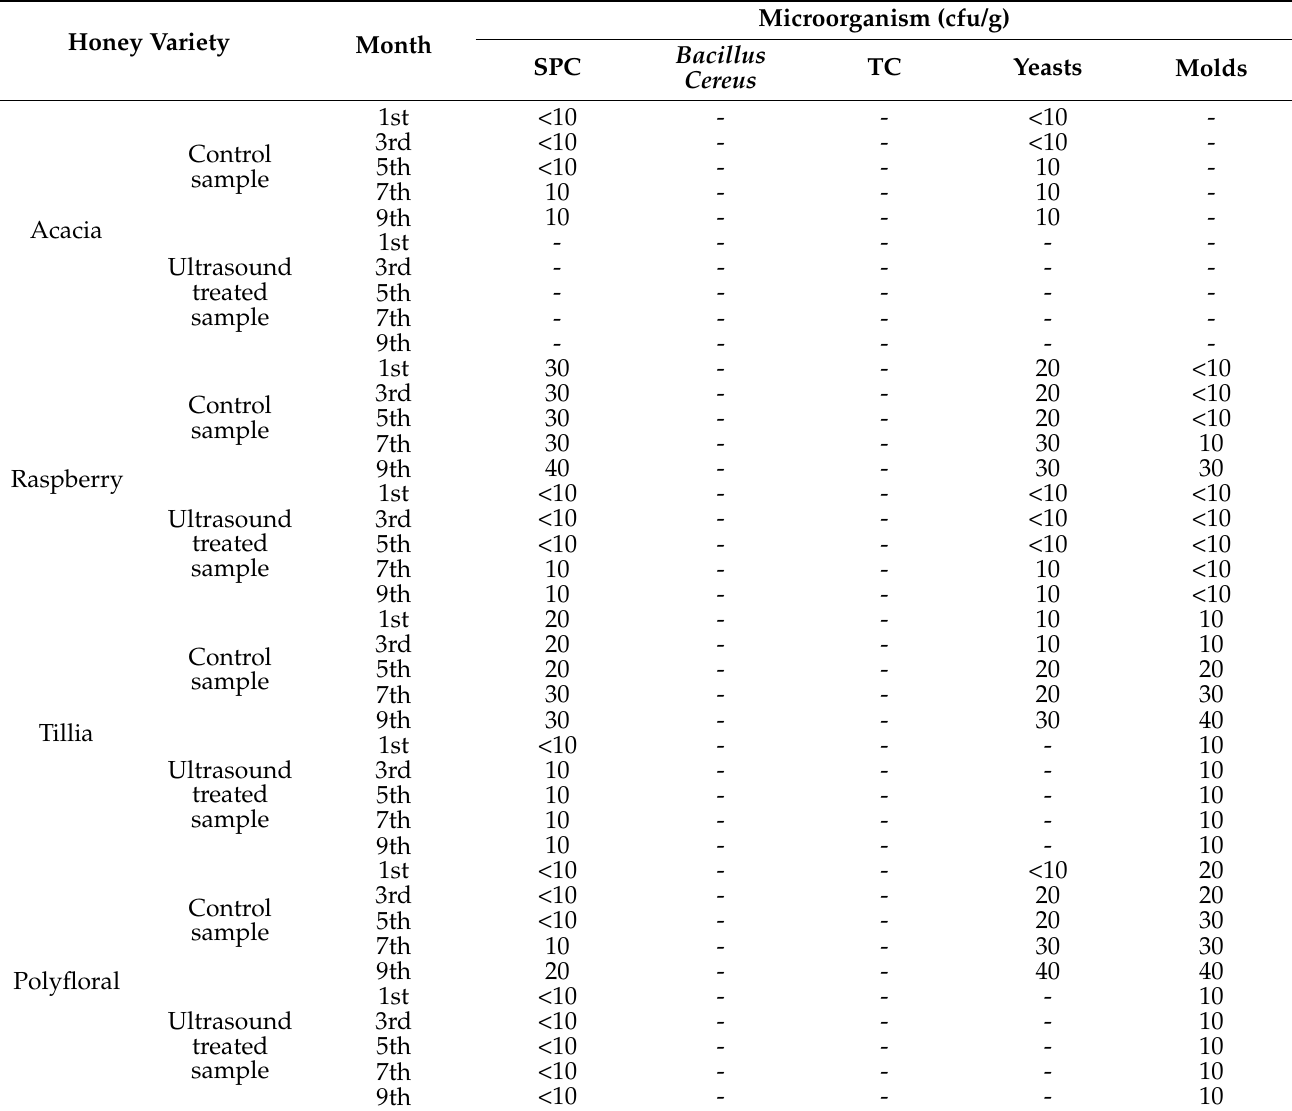
Table 2. Results of microbiological determination of honey